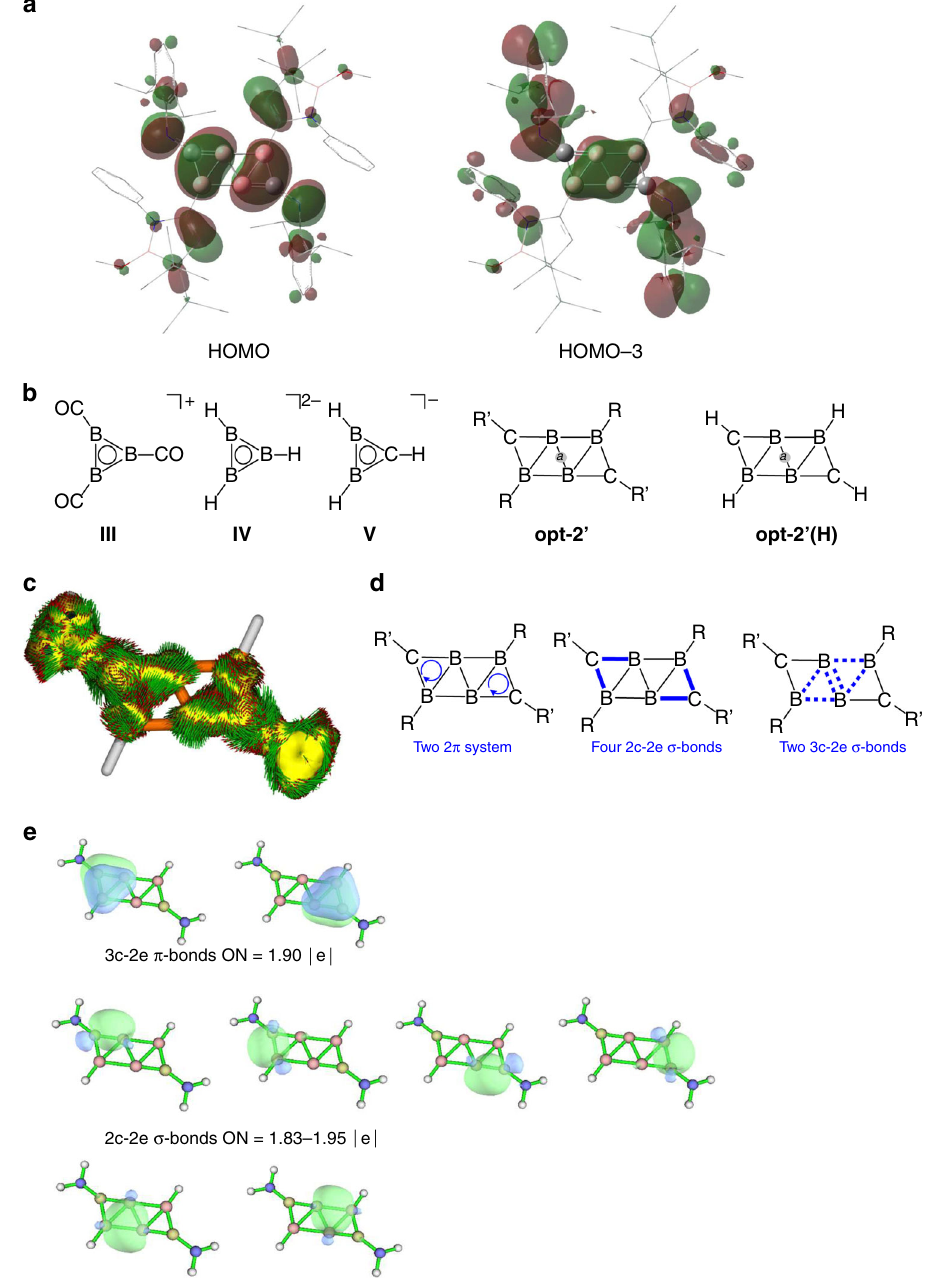
Fig. 3 Computational studies of 2. a Plots of the key molecular orbitals of opt-2 ′ . b Calculated NICS values (in ppm) of III – V , opt-2 ′ , and opt-2 ′ (H) at the B3LYP/6-311G** level of theory. c ACID plot of π framework of C 2 B 4 H 2 (NH 2 ) 2 opt-2 ″ at an isosurface value of 0.025. d Schematic drawings indicating the π - and σ -bonding electrons (blue clockwise arrows and blue solid/dashed lines respectively) in the C AdNDP method (isosurface value = 0.05).